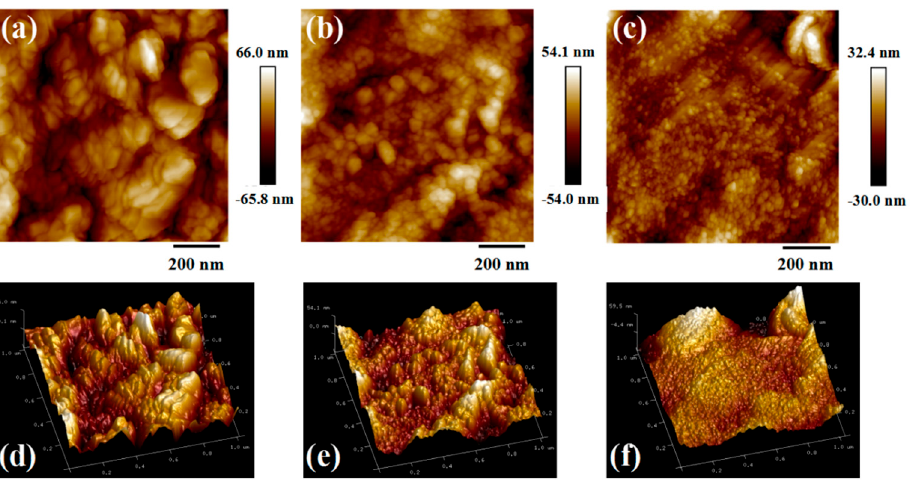
Figure 6. AFM images of the lithium metal foils: ( a , d ) original; ( b , e ) RT-1D battery; and ( c , f ) 5% FEC-RT-1D.